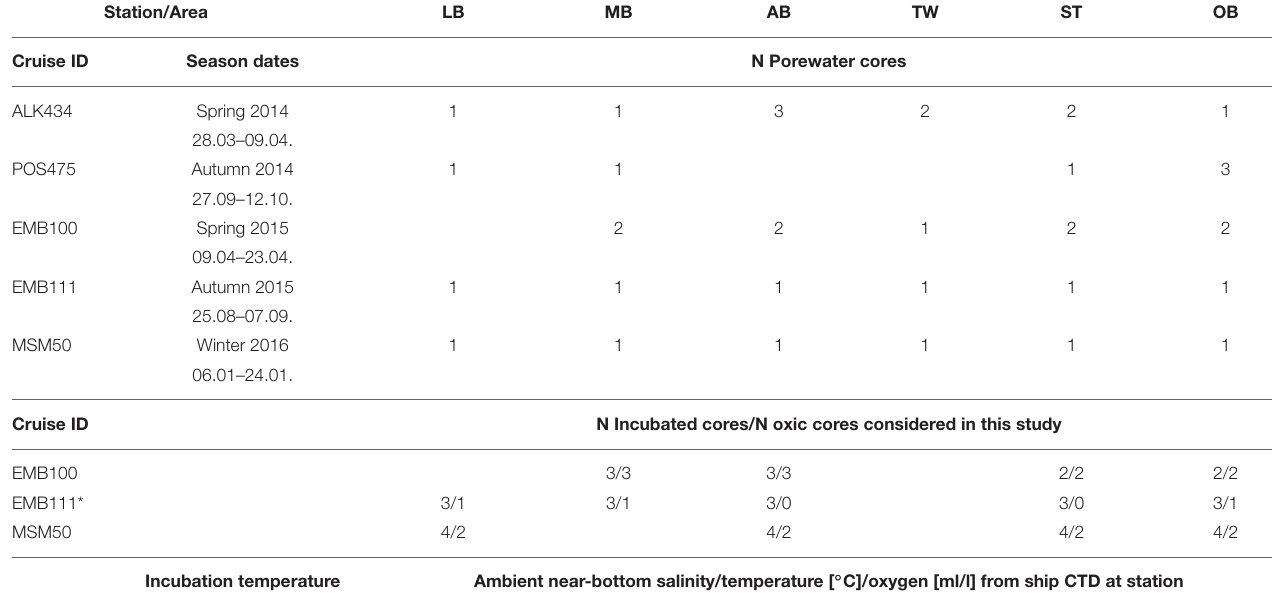
TABLE 1 | The number of cores obtained for porewater analysis and incubation experiment during each sampling event as well as values (mean ± standard deviation) of physical, chemical, and sedimentary variables measured at each station.